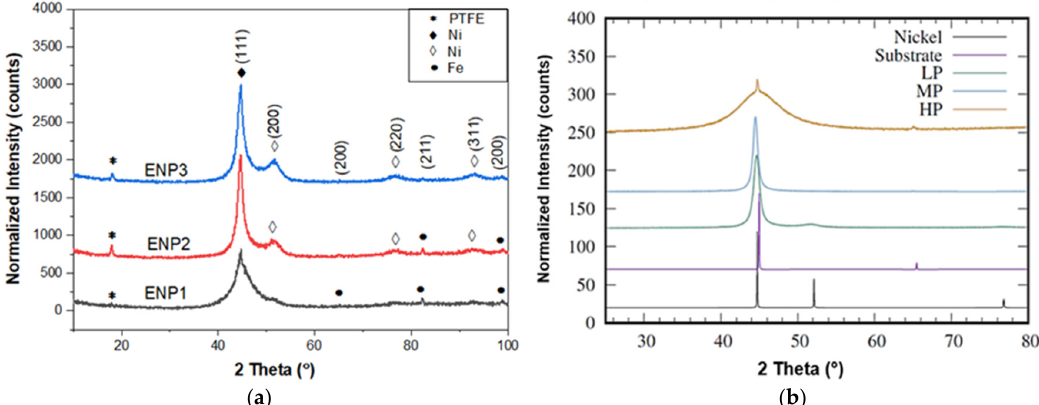
Figure 3. X-ray diffraction patterns of the deposited electroless ( a ) Ni-P matrix (i.e., MP) with embedded PTFE from the top surface ( b ) Ni-P undercoat (i.e., MP) of the ENP duplex coatings compared to LP and HP, along with the simulated patterns of nickel and the substrate. LP is low phosphorus, MP is medium phosphorus, and HP is high phosphorus.